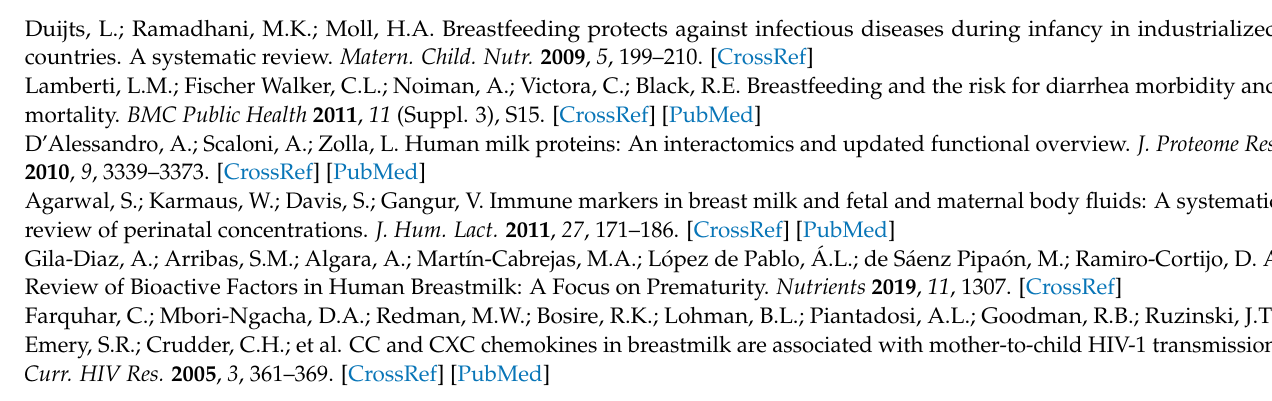
3 months. Figure S3: Hierarchical heat maps in the correlation among cytokines. Table S1: Breast milk immune components measured in this study and their impact on maternal and child health. Table S2: Comparison of positive rates and median of cytokines in breast milk at 1, 2 and 3 months according to the intervention status (probiotic vs. control). Table S3: Comparison of positive rates and median of cytokines in breast milk at 1, 2 and 3 months according to same intervention status (1 vs. 2 vs. 3 months). (A) probiotic group (B) control